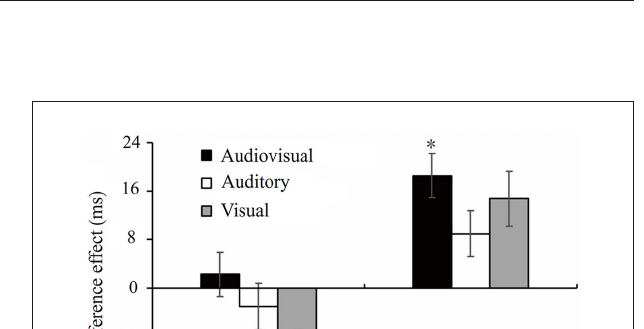
and Distractor type (auditory, visual, audiovisual vs. no distractor).